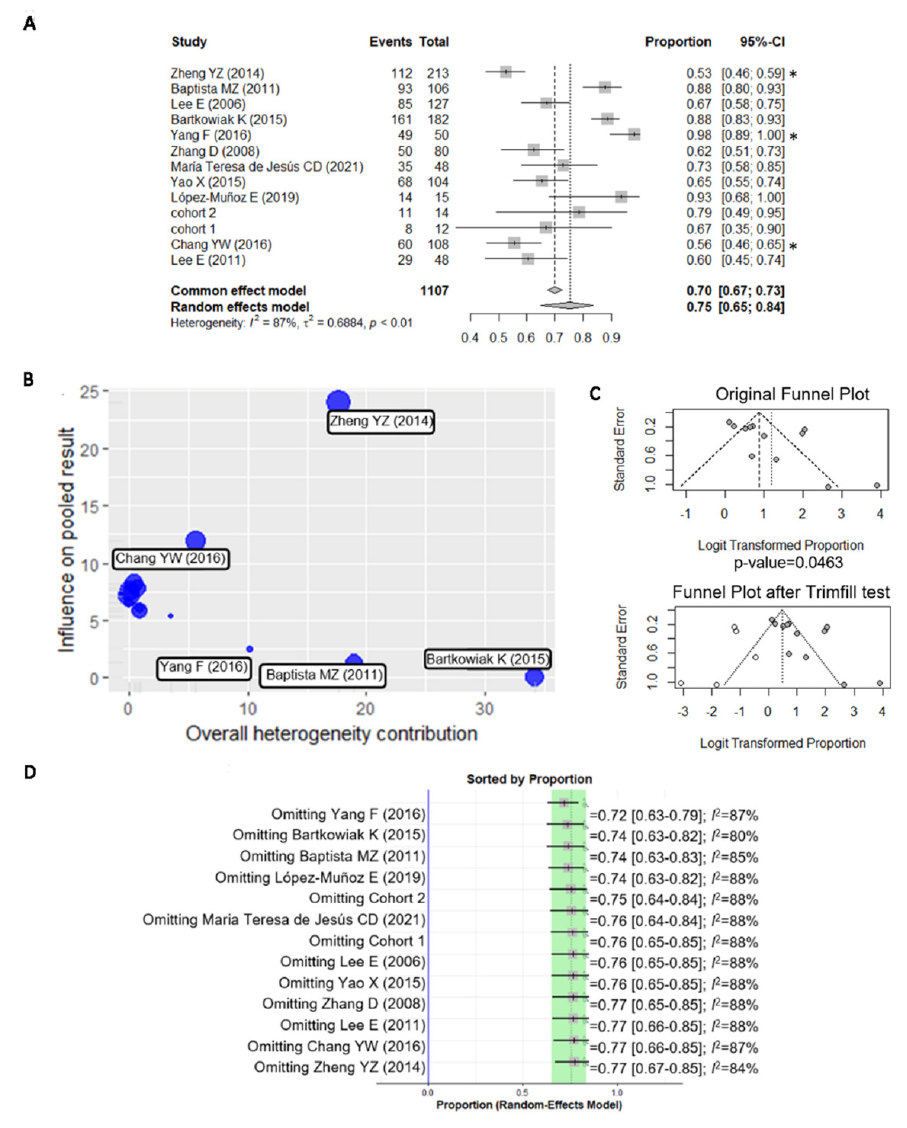
Figure 5. Quality assessment of the meta-analysis. ( A ) Forest plot showing the pooled results of BiP positive expression in breast cancer samples in the included studies: Baptista, M.Z. (2011) [6], Bartkowiak, K. (2015) [42], Chang, Y.W. (2016) [43], Lee, E. (2006) [41], Lee, E. (2011) [48], López-Muñoz, E. (2019) [47], Maria Teresa de Jesús, C. D. (2021) [46], Yang, F. (2016) [44], Yao, X. (2015) [5], Zhang, D. (2008) [45], Zheng, Y.Z. (2014) [10], cohort 1 and cohort 2; * identifies the possible outliers. CI—confidence interval. ( B ) Baujat plot comparing the weight of each study to the overall BiP staining heterogeneity; ( C ) funnel plot showing the asymmetry and publication bias for BiP and the addition of five studies with the trim-fill test. ( D ) Sensitivity analysis showing that omitting one study at a time does not influence the overall results.